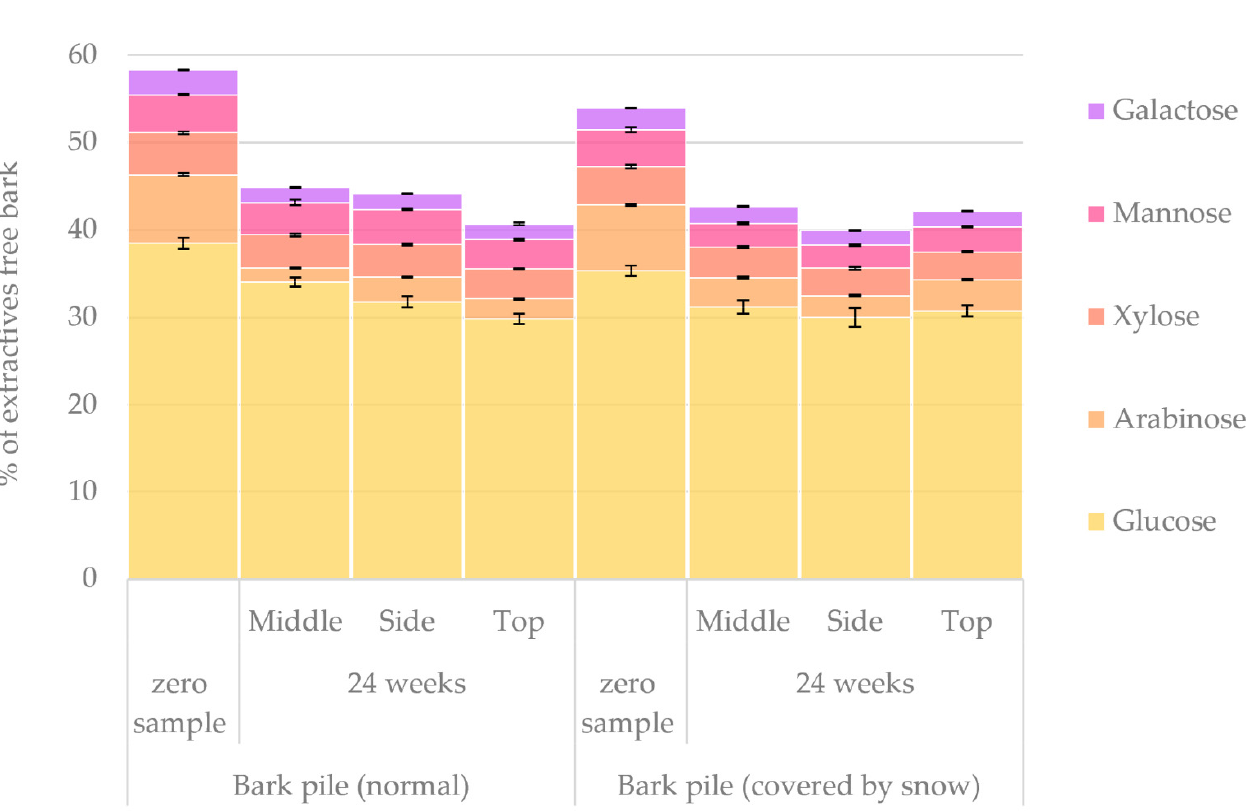
Figure 15. Quantified amounts of holocellulosic monosaccharides in bark samples at the beginning and end of normal and snow-covered pile storage.